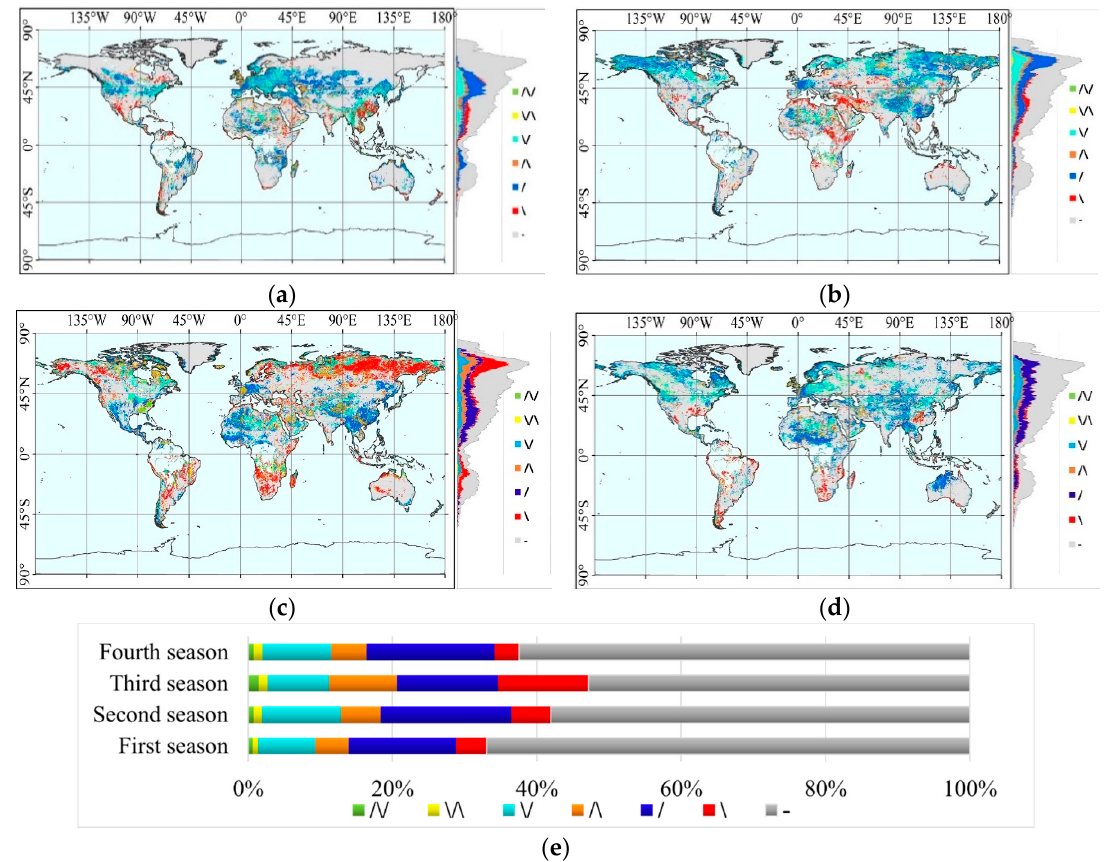
Figure 7. Spatial distribution of the different trends of SM on all valid lands and their meridional distribution during the: ( a ) first season (winter in northern hemisphere while summer in southern hemisphere), ( b ) second season (spring in northern hemisphere while autumn in southern hemisphere), ( c ) third season (summer in northern hemisphere while winter in southern hemisphere), and ( d ) fourth season (autumn in northern hemisphere while spring in southern hemisphere). ( e ) Percentage of the respective trends at each season. Symbols in panels ( a – d ) are identical to those of Figure 5.